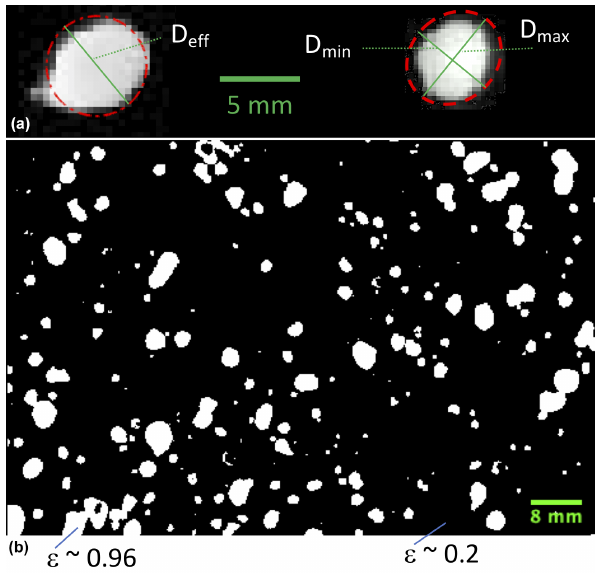
Figure 7. (b) Black and white binary thermal images of snowflakes in various stages of melting and evaporation on the DEID heated plate observed at Alta. (a) A close-up image illustrating the defini- tions of D eff , D min and D max . (cid:15) w of snow and aluminum are noted.